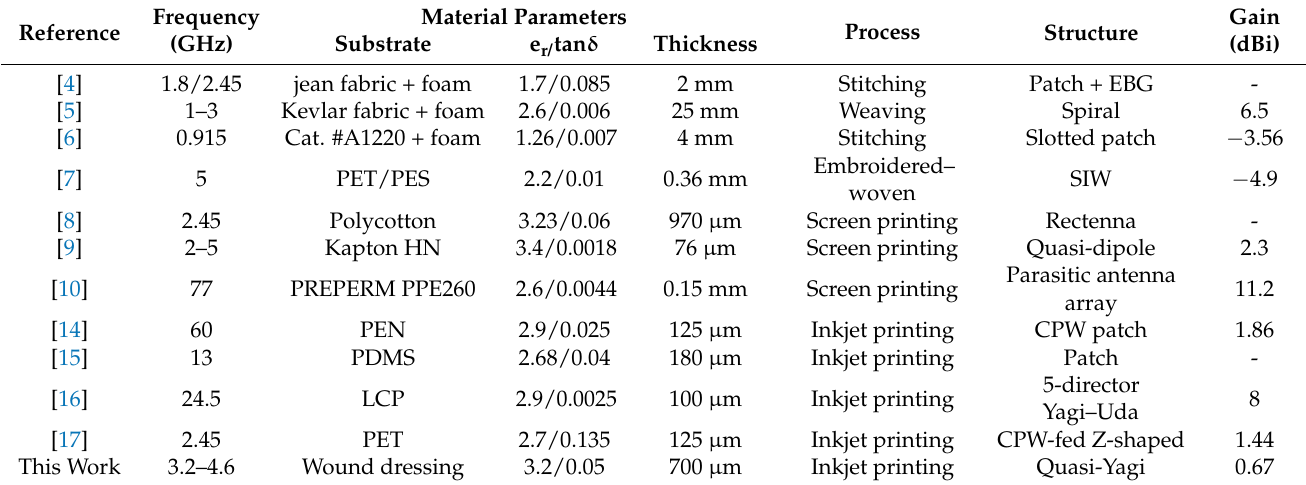
Table 1. Comparison of flexible antennae: this work and other published